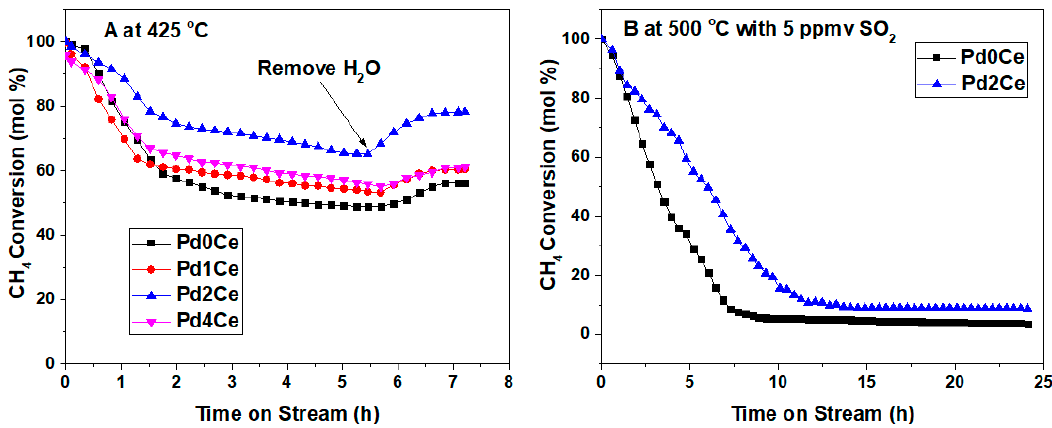
Figure 5. TOS results after adding: ( A ) 10 vol.% H 2 O added to the dry feed gas at 425 °C and ( B ) 10 vol.% H 2 O and 5 ppmv SO 2 added to the dry feed gas at 500 °C. Reaction conditions: GHSV = 36,000 h − 1 , Feed gas composition: 0.07 vol.% CH 4 , 8.5 vol.% O 2 , 0.06 vol.% CO, 8 vol.% CO 2 in N 2 and He.